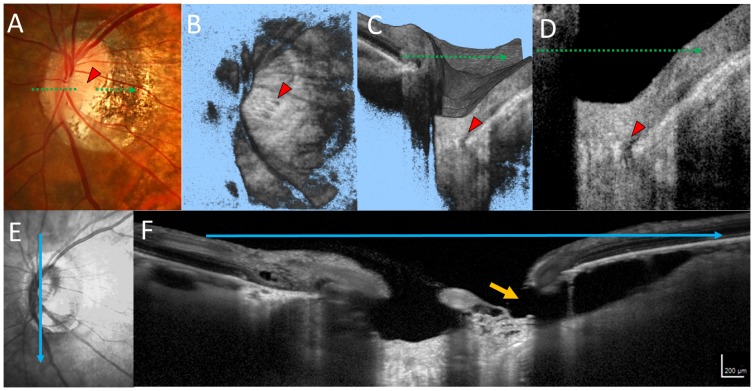
A representative case of an eye with primary open angle glaucoma, a lamina cribrosa (LC) defect, and peripapillary intrachoroidal cavities (PICCs).(A) A dark yellowish-orange lesion was seen in the area inferior to the optic disc. The LC defect is visible in the en face image (B), volume scan image (C), and B-scan image (D, red arrowhead). The infrared image (E) and spectral domain optical coherence tomography B-scan image (F), oriented at the blue arrow in (E), are shown. PICCs are visible as hyporeflective cavities between Bruch's membrane and the sclera. The retinal nerve fiber layer was not visible at the orange arrow.